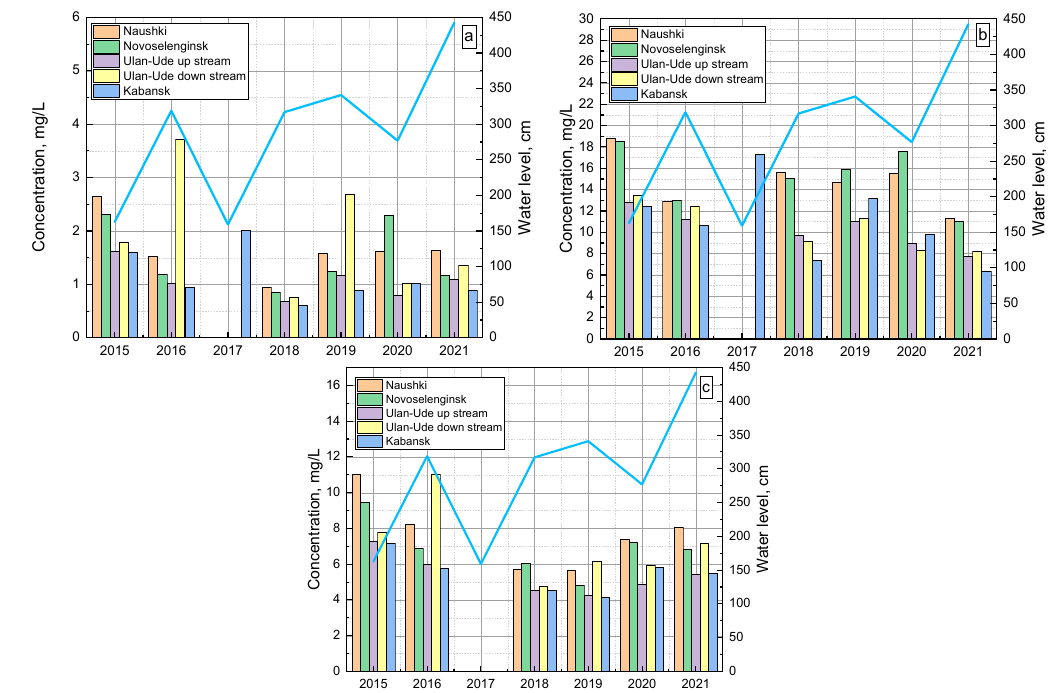
Figure 10. Spatiotemporal changes in the content of major ions in the Selenga water (( a )—Cl − , ( b )— SO 42 − , ( c )—Na + ). (Data on Na + ion content for 2017 are not available).